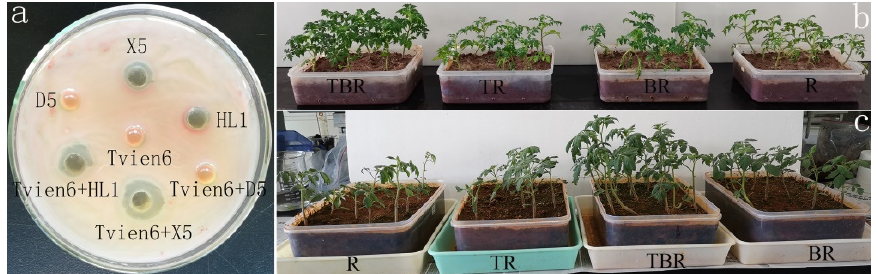
Figure 1. Effect of Trichoderma virens (Tvien6) and Bacillus velezensis (X5) on Ralstonia solanacearum (RS-15) and tomato plants. ( a ) In vitro antagonistic activity of single culture and cocultured filtrates of Tvien6 and X5 against Ralstonia solanacearum . D5 and HL1 are Bacillus velezensis , but they were not used in this study; ( b , c ) Effect of Tvien6 and X5 on tomato plant growth; the treatments were as follows: R = RS-15; TR = Tvien6 + RS-15; BR = X5 + RS-15; and TBR = Tvien6 + X5 + RS-15. For ( b ), three replicates were conducted for each treatment, with five basins per replicate, and each basin contained six seedlings. For ( c ), three replicates were conducted for each treatment, with five basins per replicate, and each basin contained 15 seedlings.